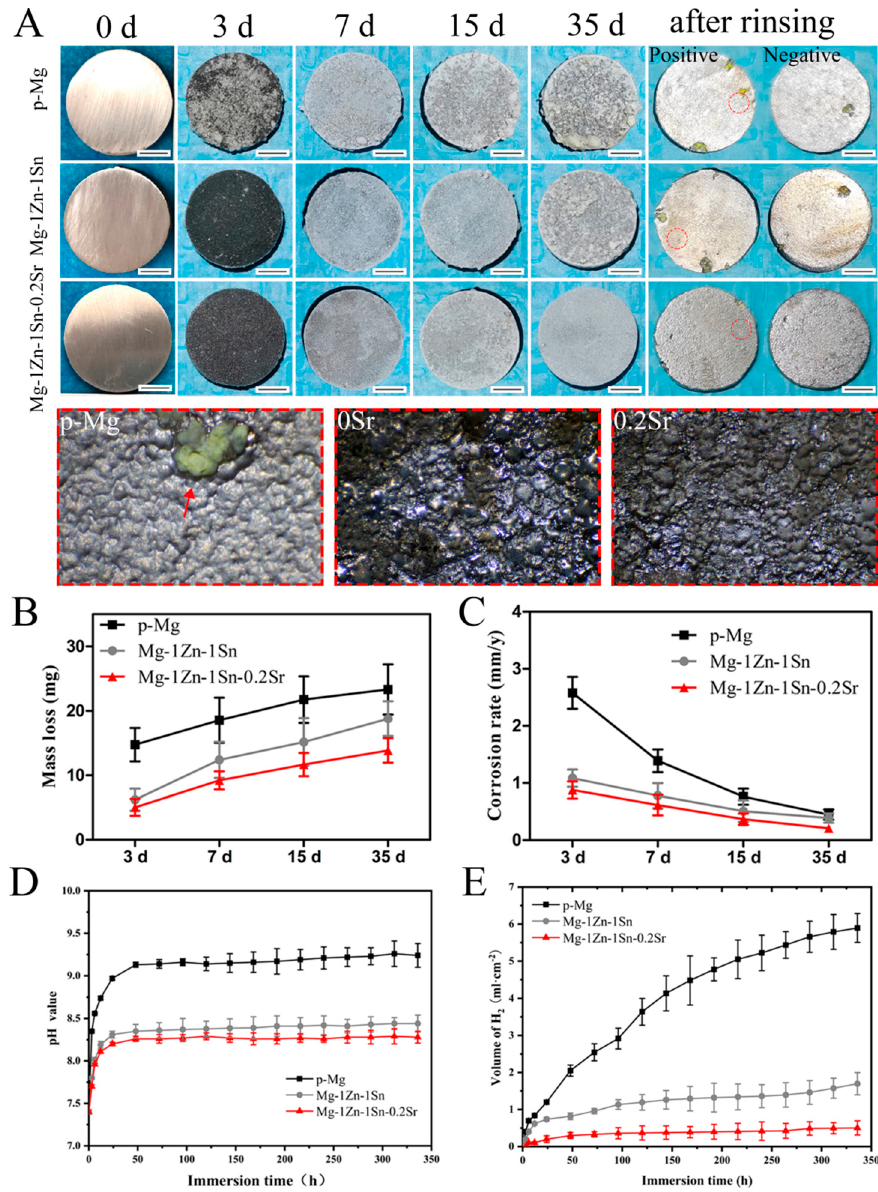
Figure 4. ( A ) Macroscopic images of p-Mg, Mg-1Zn-1Sn and Mg-1Zn-1Sn-0.2Sr at each prescribed time point during 35 days of immersion degradation in SBF. All wafers had a starting dimension of 15 mm in diameter and 1 mm in thickness. The red arrow indicates the typical pitting characteristics of p-Mg. ( B ) Mass loss, ( C ) corrosion rate calculated by mass loss, ( D ) pH value and ( E ) H 2 release of p-Mg, Mg-1Zn-1Sn and Mg-1Zn-1Sn-0.2Sr at various immersion times in SBF. Scale bar = 5.